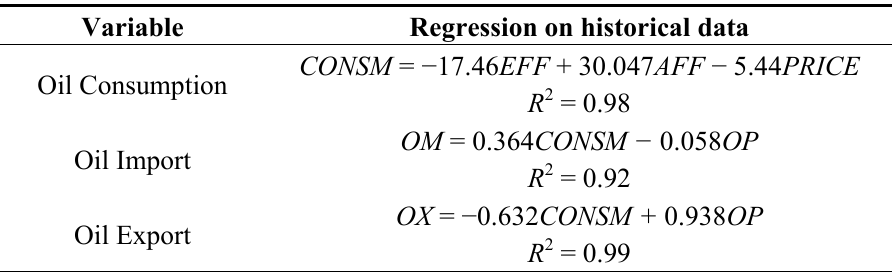
Table 2. Test on key assumed relationships.